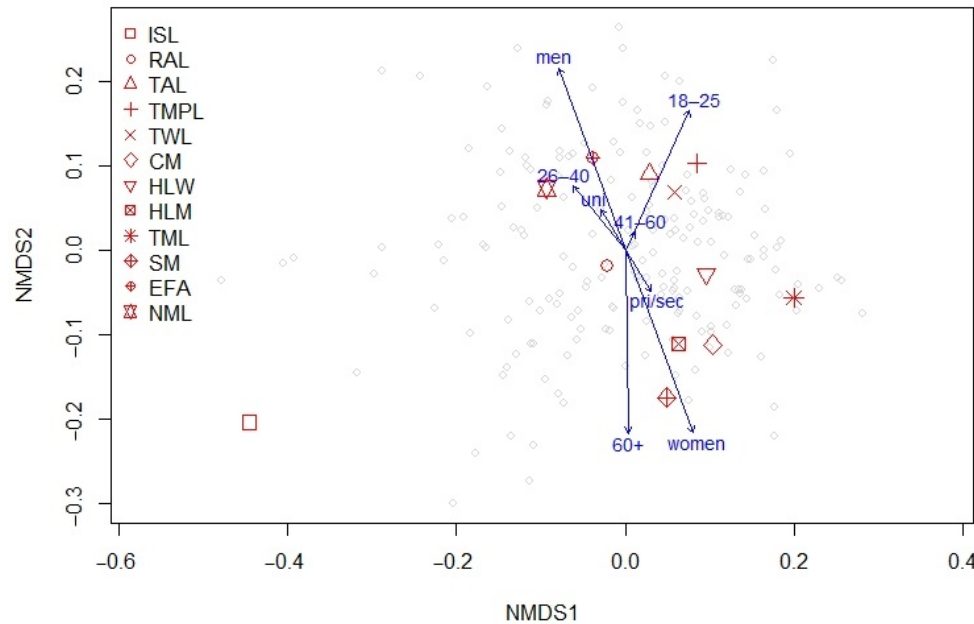
Figure 9. Multidimensional scaling of respondent perceptions of landscape that they find the most endangered/degraded (Variability and preferences of respondents: uni—university educa-